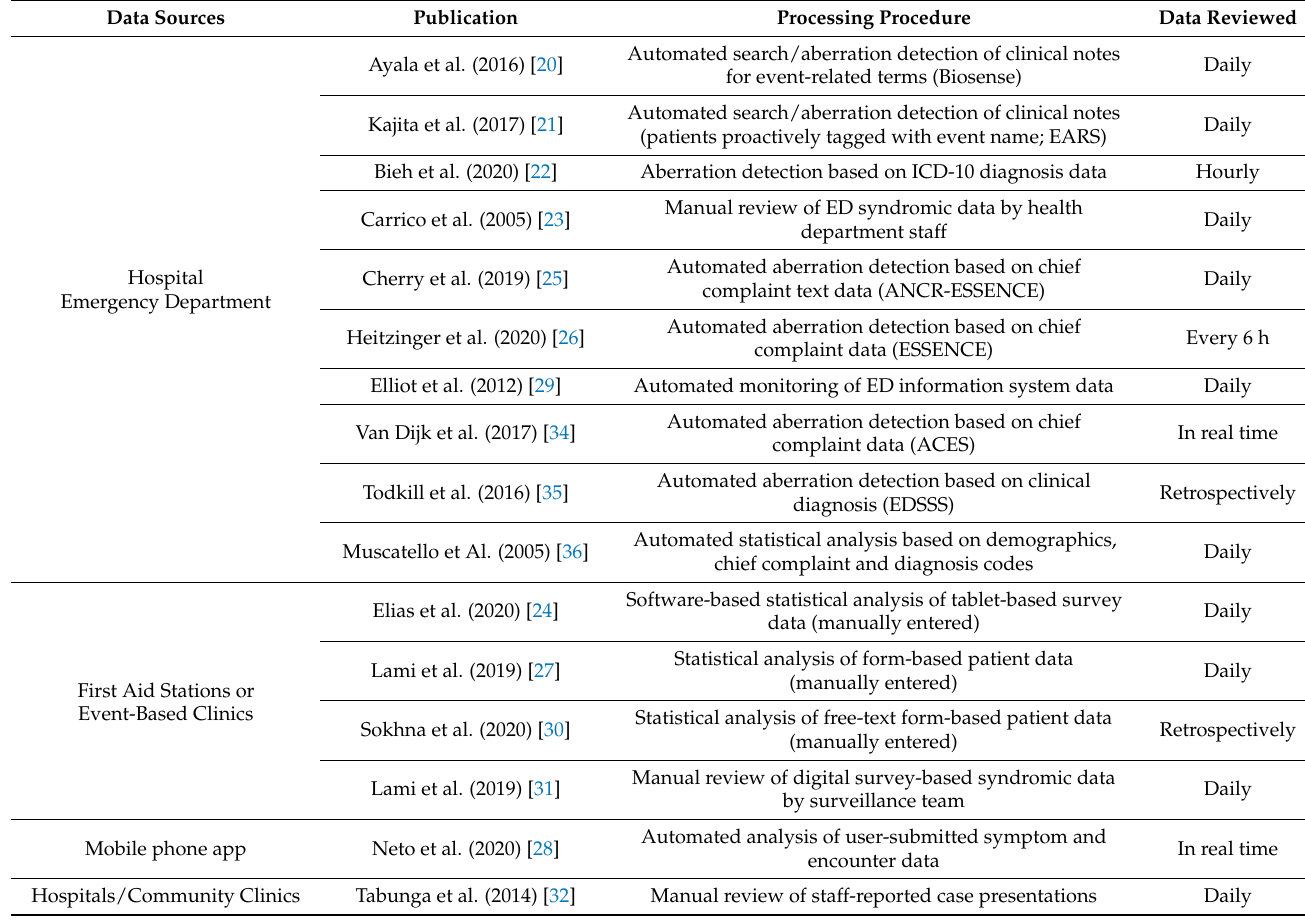
Table 2. Data sources and processing